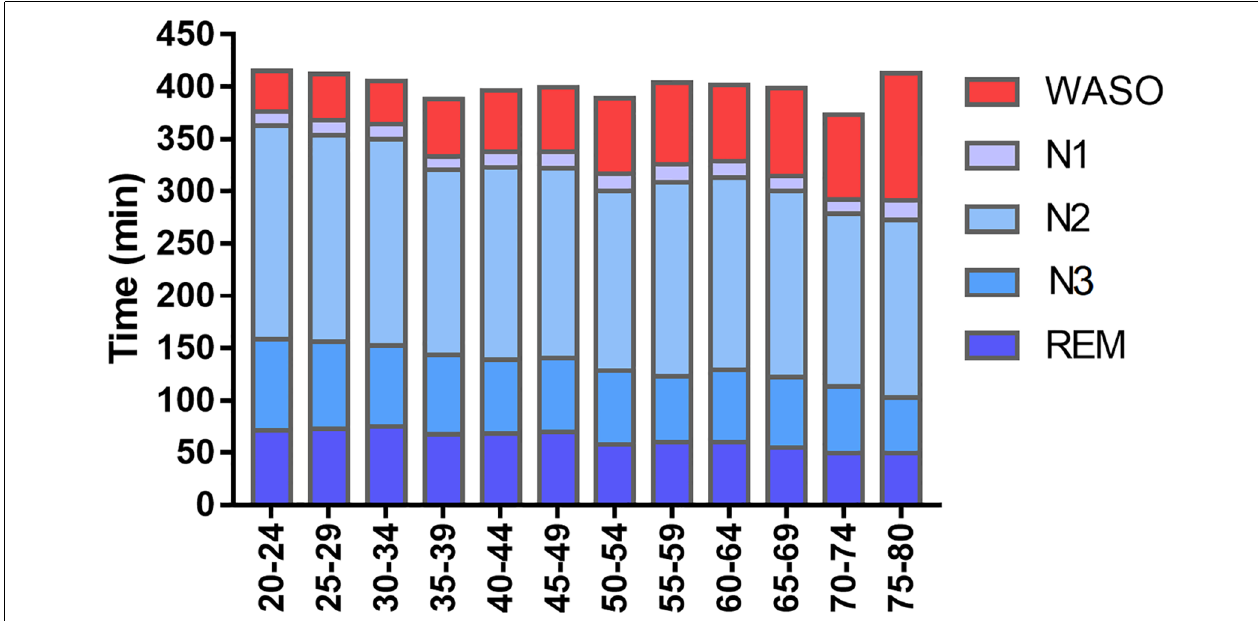
FIGURE 1 | Sleep structure throughout the lifespan. Values obtained in relation to prevalence obtained by the São Paulo Epidemiologic Sleep Study. Comparing the 20–24 to the 75–80 age strata, reductions in total sleep time (376–291 min), N3 sleep (87–53 min) and REM sleep duration (70–49 min), and an increase in time awake after sleep onset (WASO: 39–141 min) can be observed. A reduction in sleep efficiency (87–64%) and an increase in sleep latency (14–35 min) were also observed (data not shown). The reductions in N3 and REM sleep should be contextualized in respect of the global reduction in total sleep time. In terms of percentage, REM sleep proportion stays stable (18–17%) while slow-wave sleep is subjected to a small reduction (24–18%). Adapted from Moraes et al.